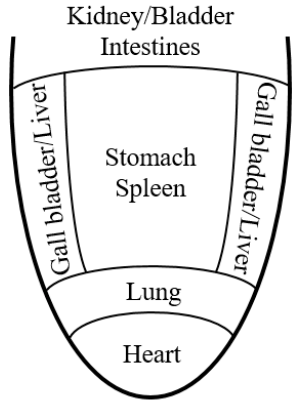
Figure 1. Tongue somatotopy in Chinese medicine diagnosis.